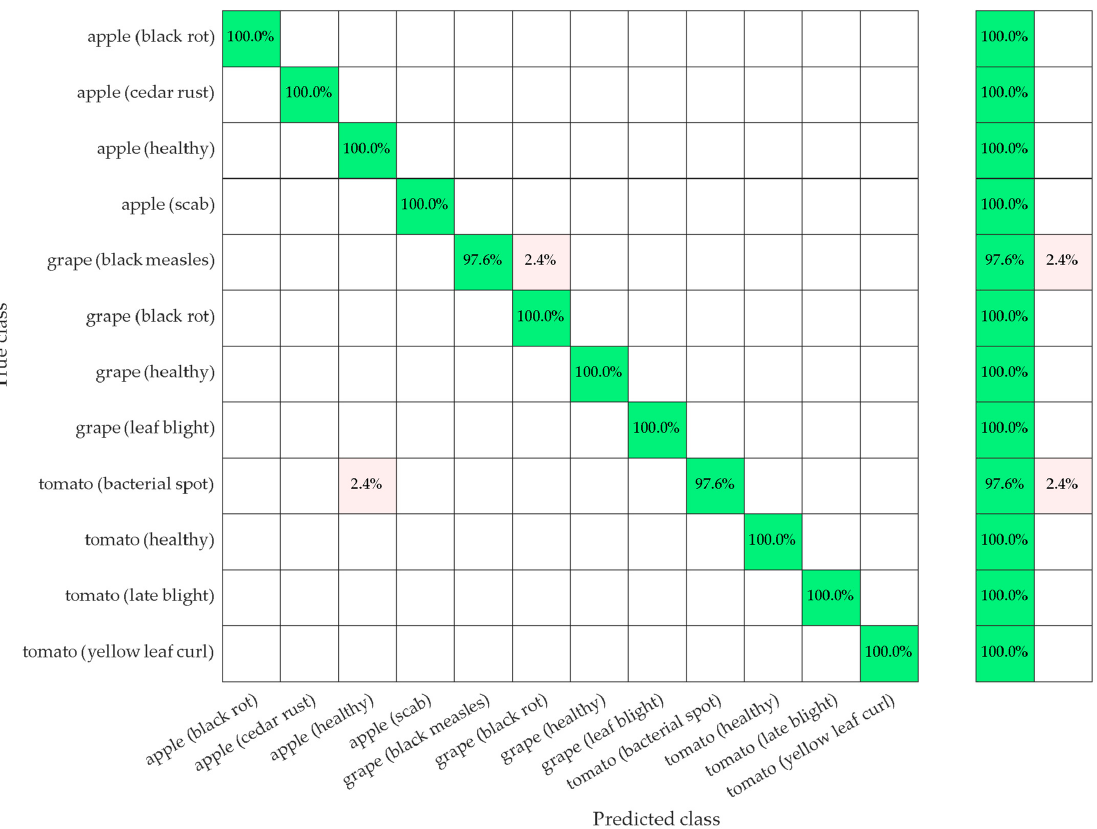
Figure 8. Confusion matrix for the proposed apple, grape, and tomato plant leaf disease classification model. Table 8. Comparison of the performance of various classifiers created with the selected features by the proposed FPA-SVM and PSO-SVM wrapper approaches for wavelet families providing the best classification performance.